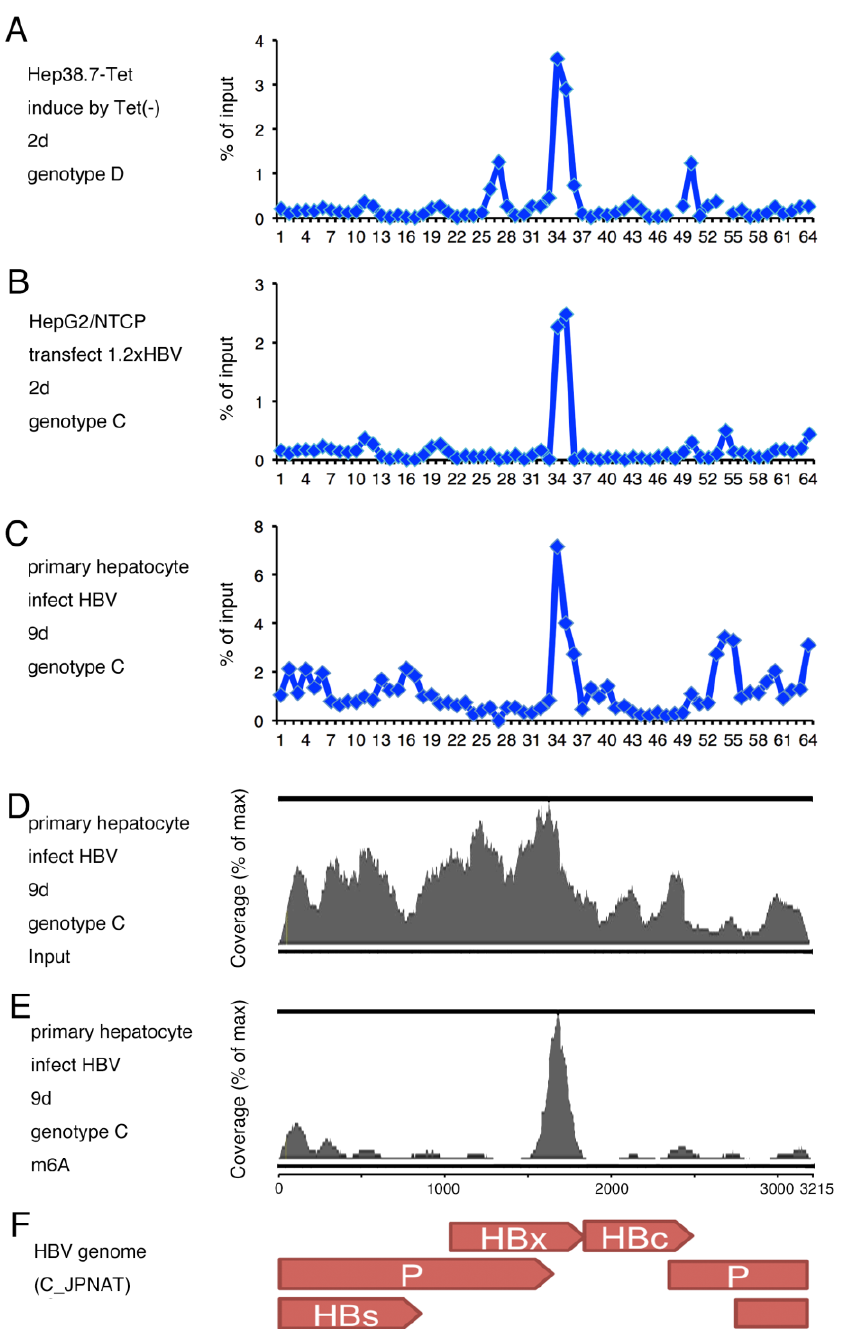
Figure 1. Modification of HBV RNA by m 6 A . ( A ) Transcription of HBV RNA was induced by removing tetracycline from the culture medium of Hep38.7-Tet cells for 2 days. ( B ) HepG2/NTCP cells were transfected with pUC1.2xHBV and incubated for 2 days. ( C – E ) Primary human hepatocytes (PHHs) were infected with HBV with 4% PEG and incubated for 9 days. ( A – C ) RNA was isolated and subjected to MeRIP analysis followed by qRT-PCR. We prepared 64 sets of oligonucleotide primers that covered the whole HBV pregenome RNA. The precipitated RNA level was plotted after normalization to the input level as percentage of input. ( D , E ) RNA was isolated and subjected to MeRIP analysis, which was followed by RNA-seq. Reads from input ( D ) and MeRIP-precipitated ( E ) samples were mapped to the reference HBV strain (C_JPNAT) and shown as coverage (%). ( F ) Schematic of HBV genes in the reference strain.